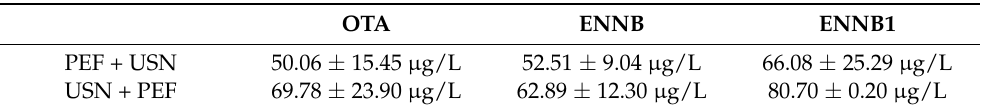
Figure 2. Reduction percentage (%) of Ochratoxin A, Enniatin B, and Enniatin B1 in orange juice with milk after PEF + USN treatment vs. after USN + PEF treatment. (ab, for each mycotoxin di ff erent le tt ers indicate di ff erent percent reduction rates between treatments) (* indicates a signi fi cant reduc- tion concerning the control). OTA: Ochratoxin A, ENNB: Enniatin B, ENNB1: Enniatin B1, USN: Ultrasounds, PEF: Pulsed Electric Fields. Table 3. Contents of Ochratoxin A, Enniatin B, and Enniatin B1 in orange juice with milk after the combination of treatments selected.